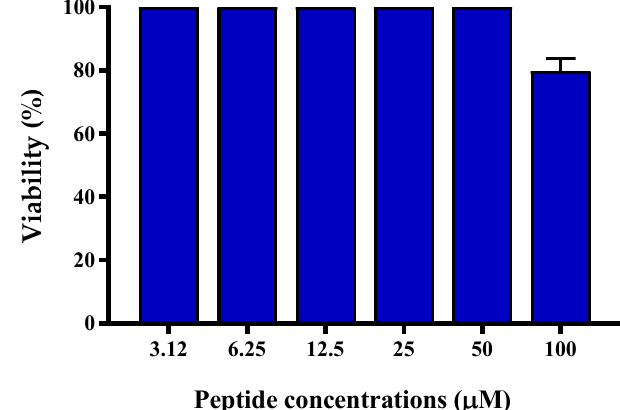
Figure 5. Percentage of HaCaT cell viability, as determined by the MTT assay, after exposure to increasing concentrations of TG for 24 h. Data are expressed as the mean of three independent experiments ± S.E.M. The value corresponding to 100 µM is statistically significant ( p < 0.05) compared to the other peptide concentrations.